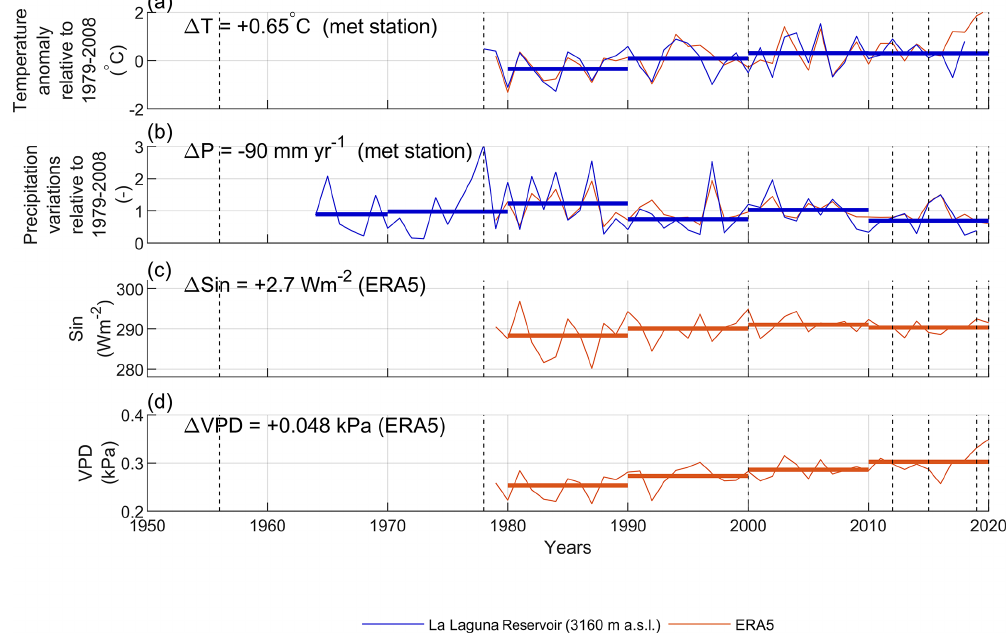
Figure 9. Annual time series of (a) mean annual air temperature, (b) total annual precipitation, (c) mean annual incoming shortwave radiation ( S in ), and (d) vapour pressure deficit (VPD) are shown in thin continuous lines. Decadal averages are shown in thick continuous horizontal lines. While panels (a) and (b) are variables recorded at La Laguna station, panels (c) and (d) are variables extracted from the ERA5-Land climate reanalysis. Vertical dashed black lines correspond to the years in which Tapado Glacier DEMs are available. (cid:49) values correspond to differences between decadal averages over the 2010s and the 1980s. The location of the automatic weather station (AWS) is shown in Fig. 1.